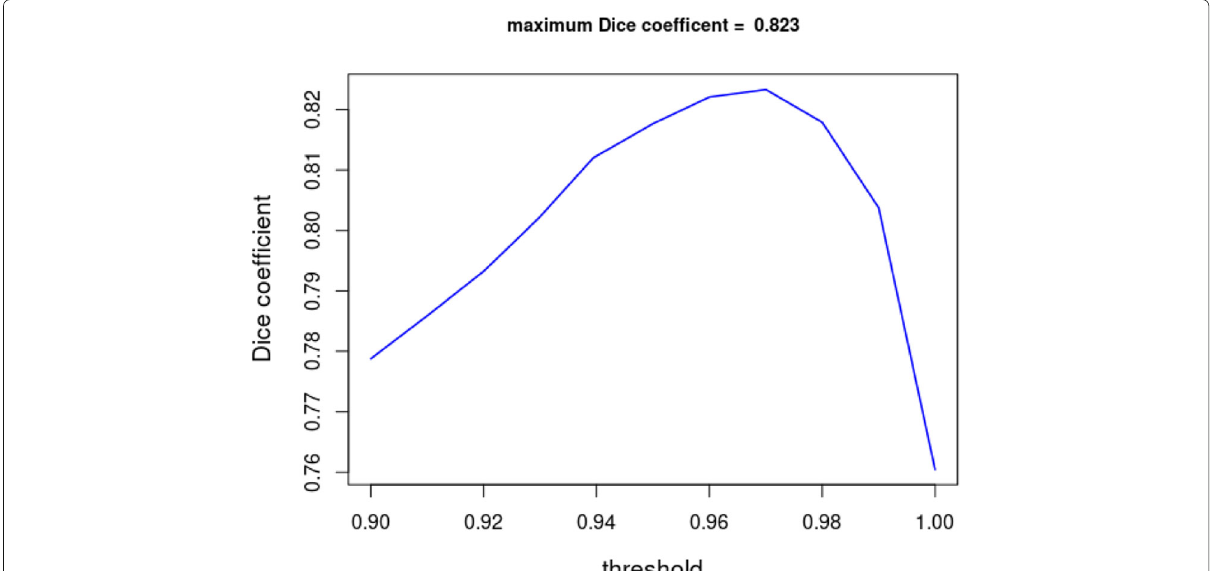
Fig. 4 Dice coefficient as a function of probability